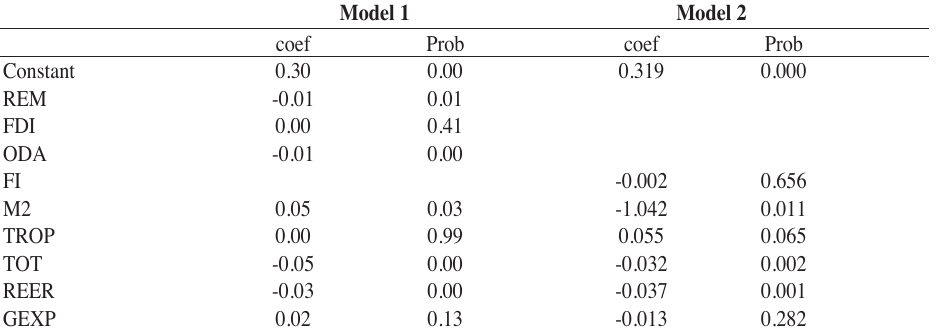
Table 4 : From Overvaluation to TFP